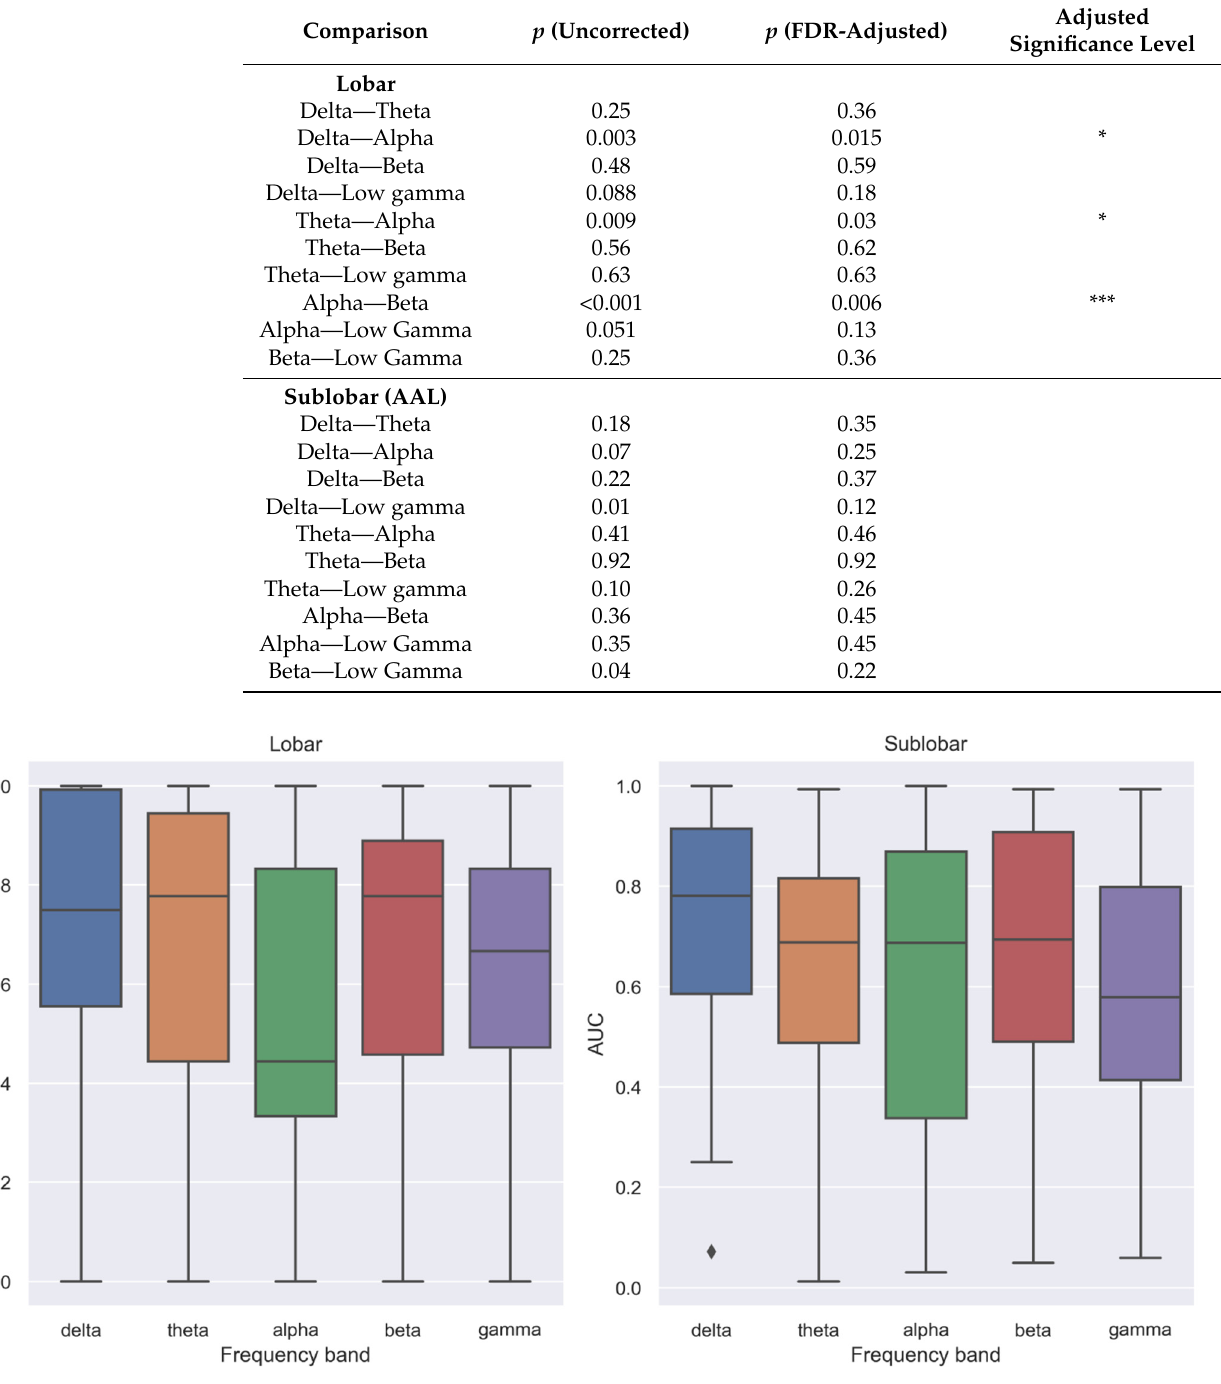
Figure 2. Overview of localization performance of node degree in different frequency bands for the seizure onset in invasive EEG on a lobar and sublobar (AAL atlas region) level.